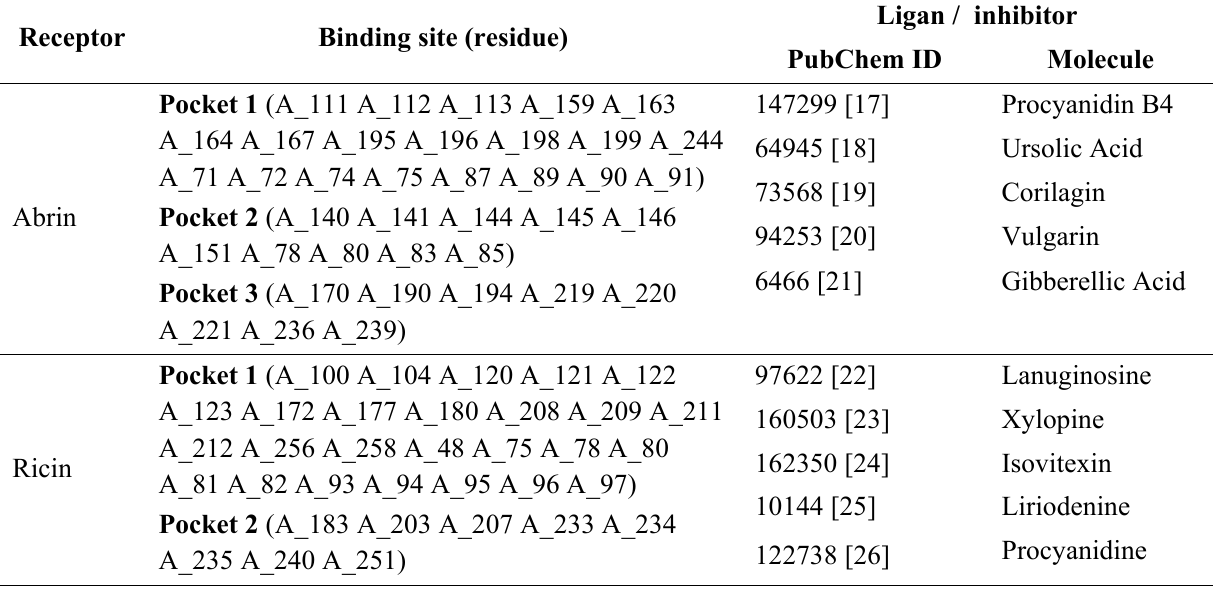
Table 1. Binding site prediction results and five compounds that have the best potential as abrin and